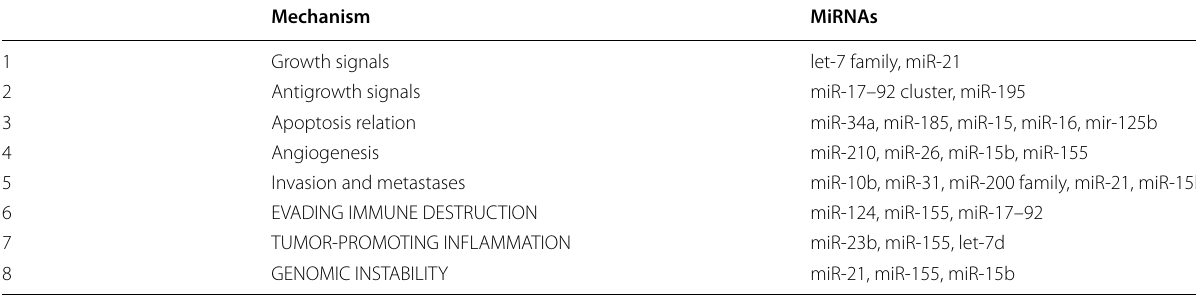
Table 3 Examples of some miRNAs and indicating their roles in